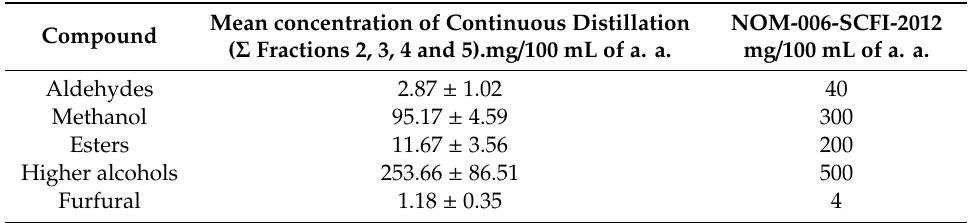
Table 1. Results of the major volatile profile for the final distillate obtained by continuous distillation. Mean concentration of Continuous Distillation Compound ( Σ Fractions 2, 3, 4 and 5).mg / 100 mL of a. a.